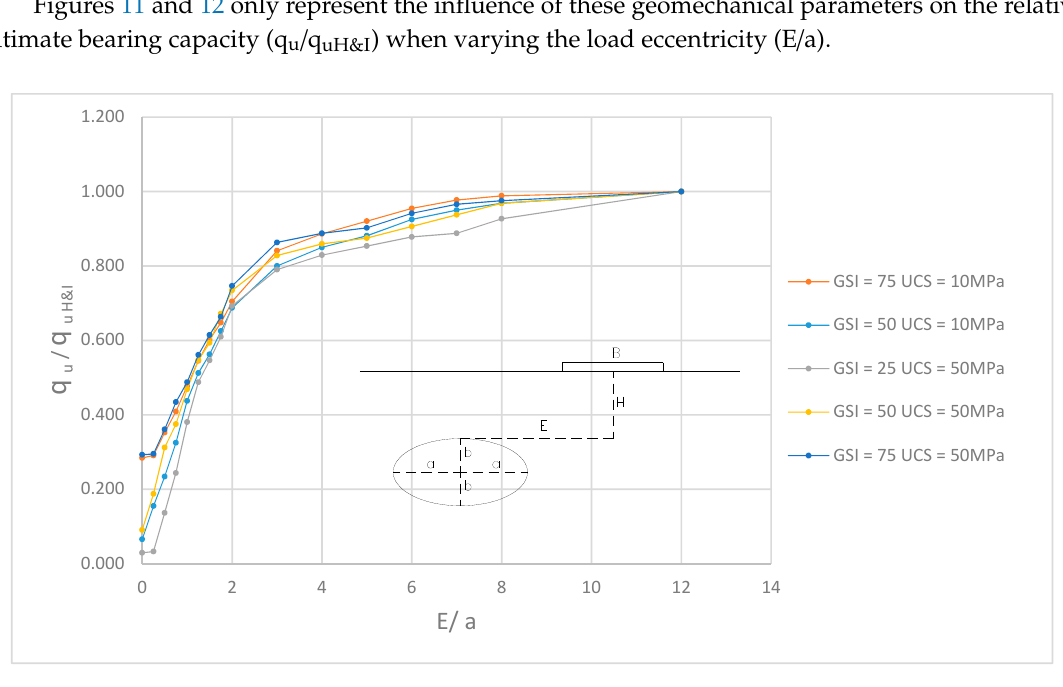
Figure 11. Influence of the geomechanical parameters of the rock, UCS and GSI, on the ultimate bearing capacity value when varying the load eccentricity.